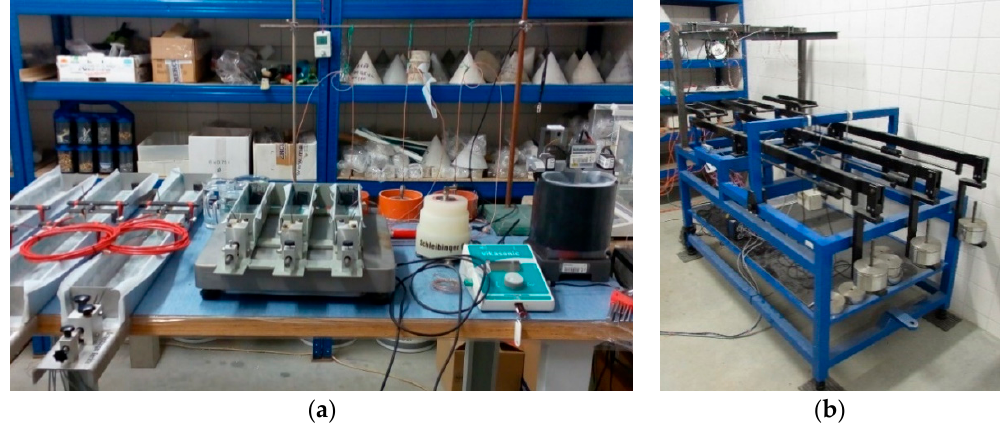
Figure 2. Overall view before concreting ( a ); weighing table for ShM_100 mm × 60 mm × 1000 mm ( b ).